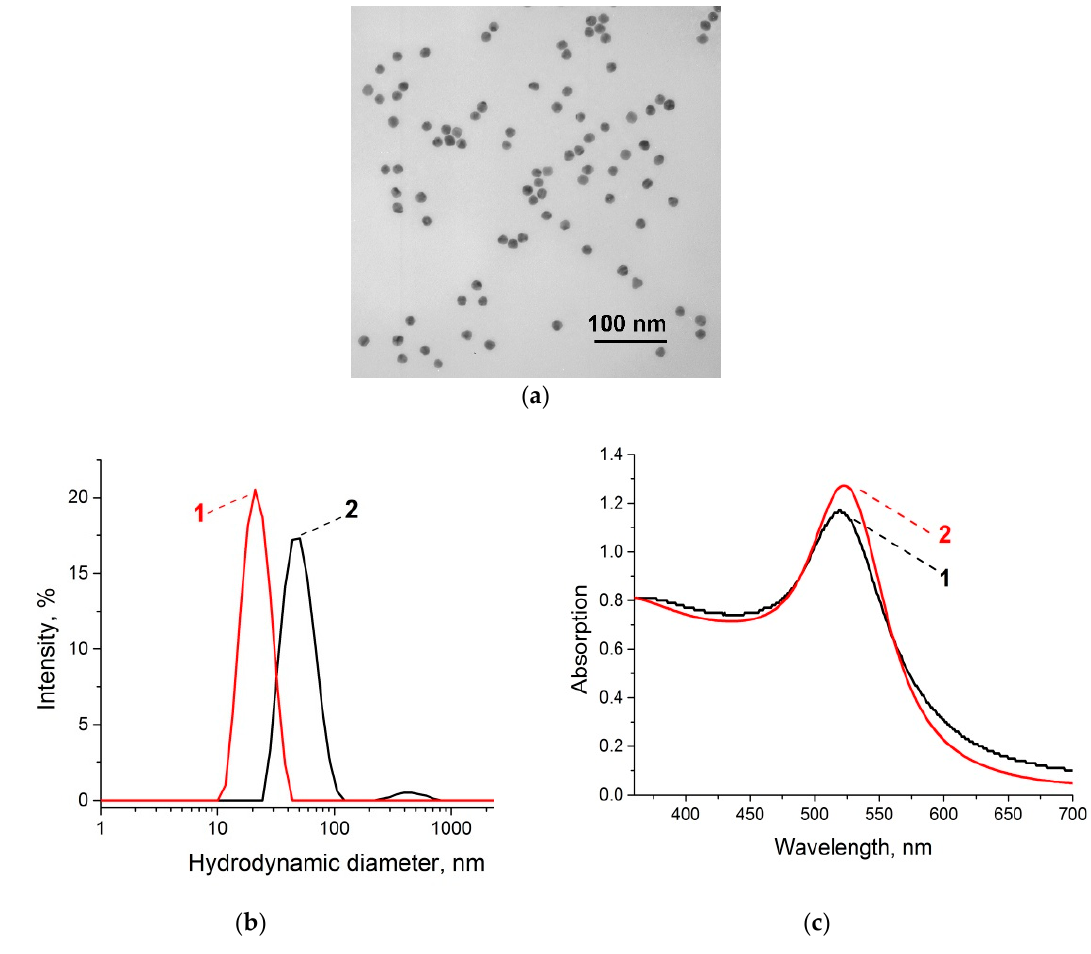
Figure 3. Characterization of the GNPs and GNP–antibody conjugate: ( a ) TEM image of GNPs; ( b ) DLS graphs of GNPs (1) and GNP–antibody conjugate (2); ( c ) spectra of GNPs (1) and the conjugate (2).